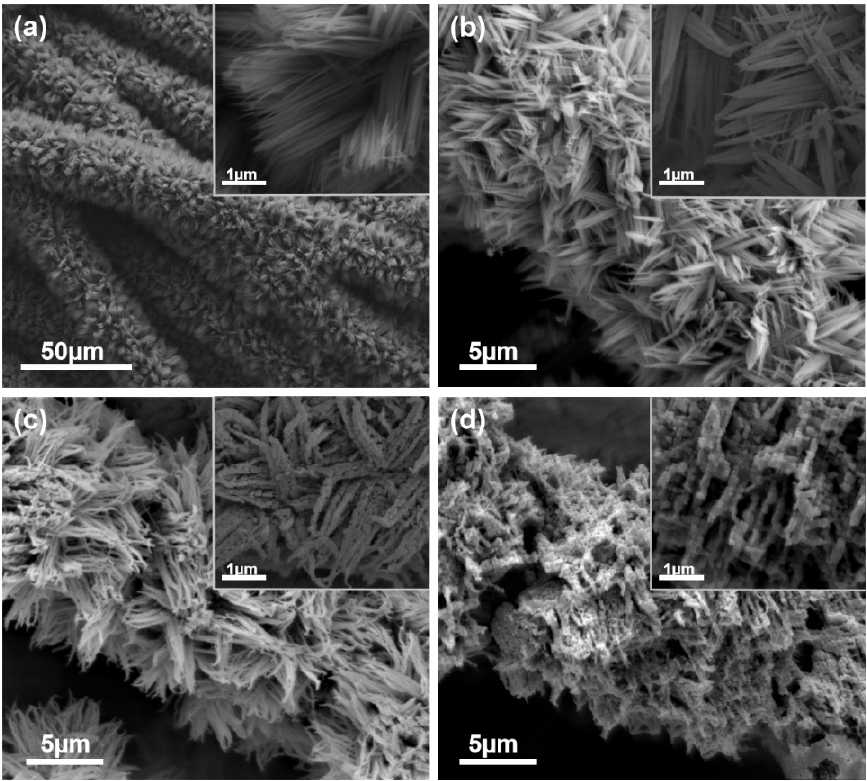
Figure 1. SEM images: ( a ) Pristine MnCo 2 O 4.5 , ( b ) S-500, ( c ) S-600, and ( d ) S-700.